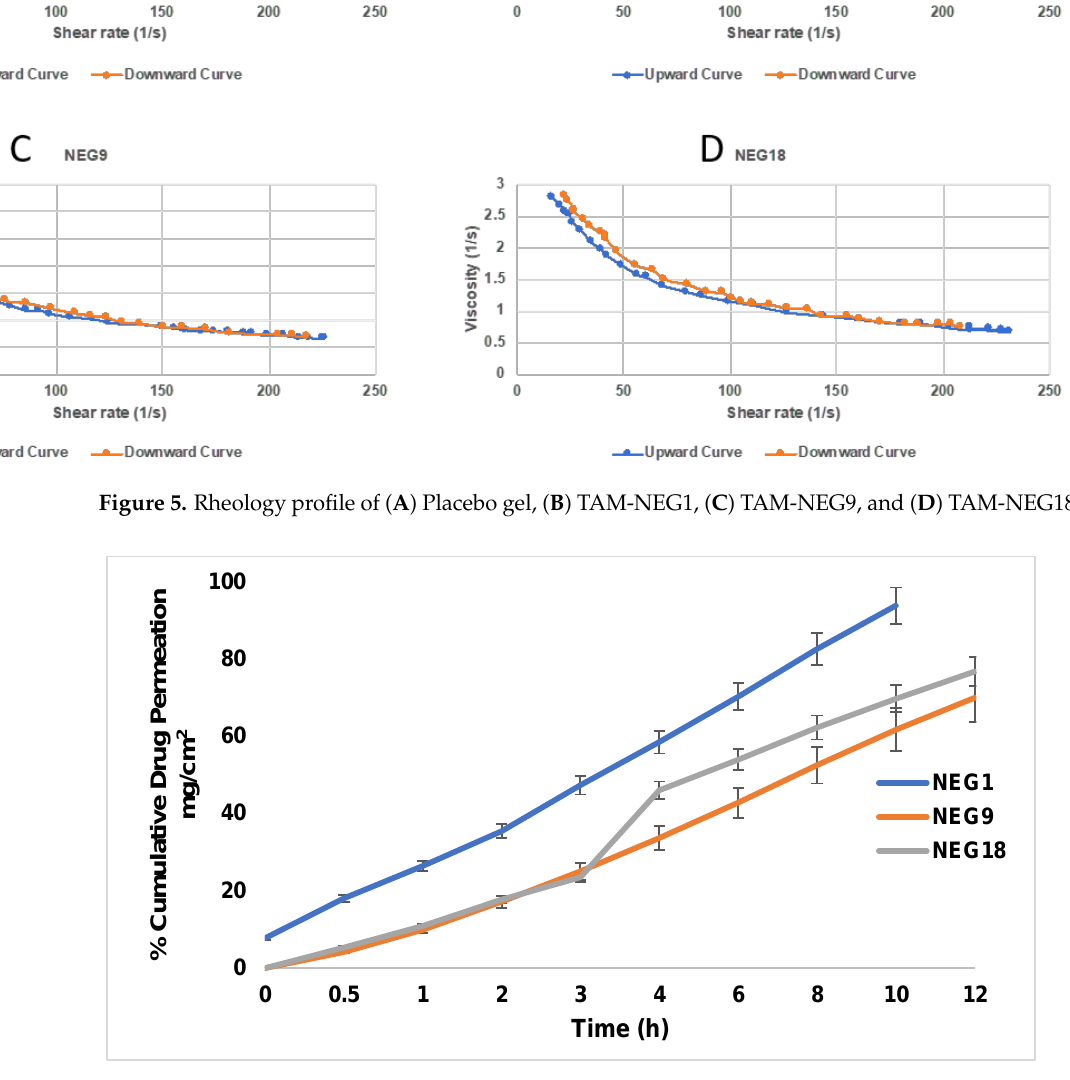
Figure 6. In vitro cumulative percentage of drug permeated via rat skin from different optimised TAM-NEG (NEG 1, NEG 9, NEG 18). Table 7. Stability study of TAM-NEGs over 30